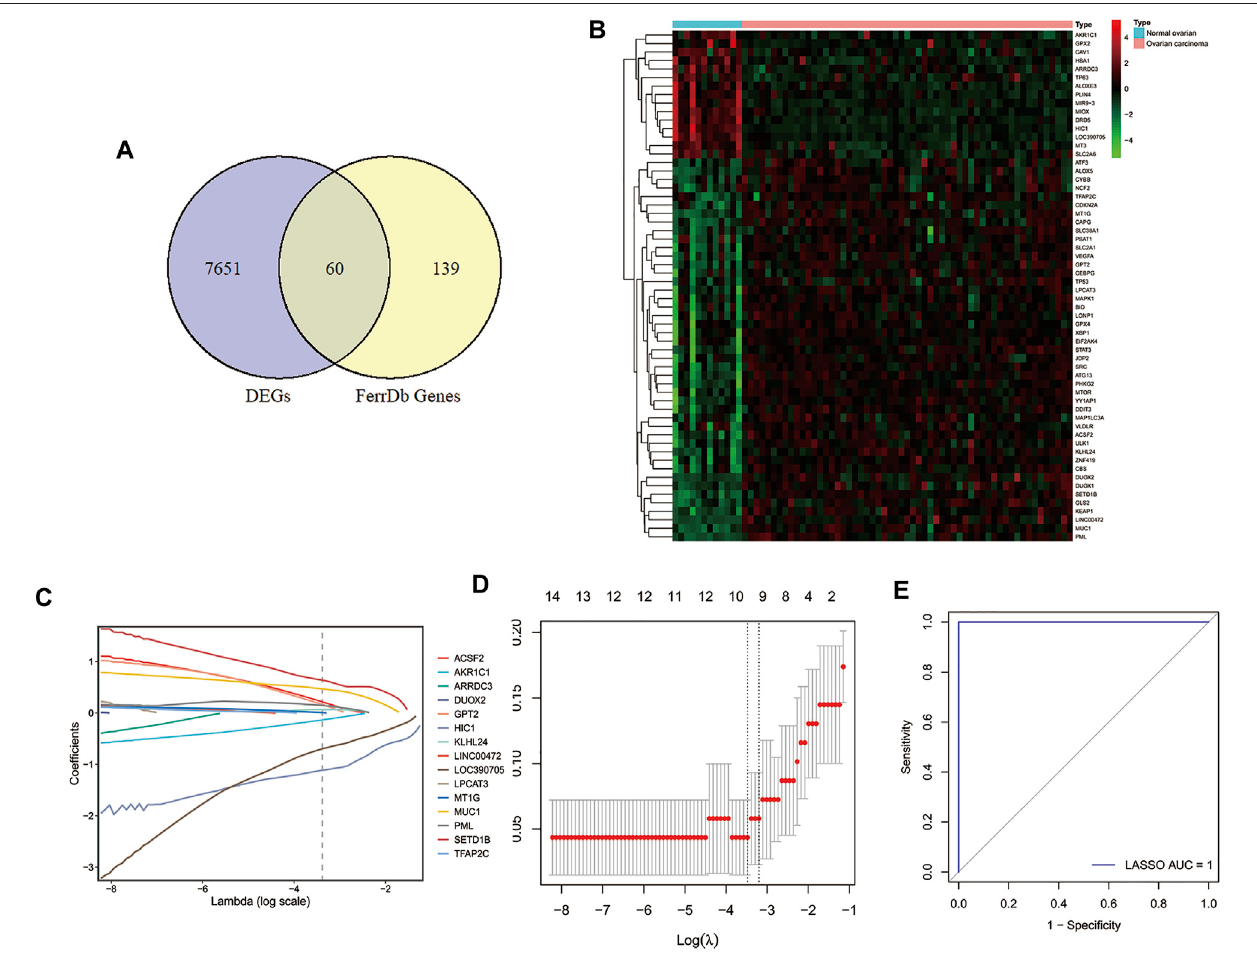
FIGURE 1 | Identi fi cation of DE-FRGs and construction of diagnostic signature with FRGs in GEO cohort. (A) Venn diagram for identifying DEGs between ovarian carcinomasamplesand normal ovariesthat belonged to FRGs. (B) Heatmap ofDE-FRGs inovarian carcinoma samplescomparedwith normal ovaries. (C) Coef fi cients ofthekeyprognosticFRGsintheLASSOmodel,eachcurverepresentsagene. (D) 10-foldcross-validationfortuningparameterselectionintheLASSOmodel. (E) ROC curve analysis of the 10-FRG diagnosis signature in GSE66957 dataset. DEGs, differentially expressed genes; DE-FRGs, Differentially Expressed-ferroptosis- related genes; FRGs, ferroptosis-related genes; LASSO, least absolute shrinkage and selection operator; ROC, receiver operating characteristic.